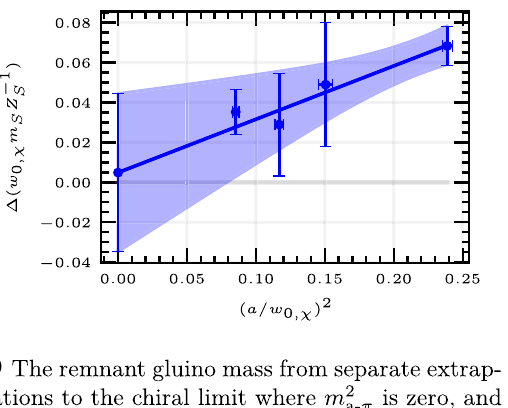
) in physical units w 0 as a function of the lattice spacing squared, and its linear extrapolation towards S